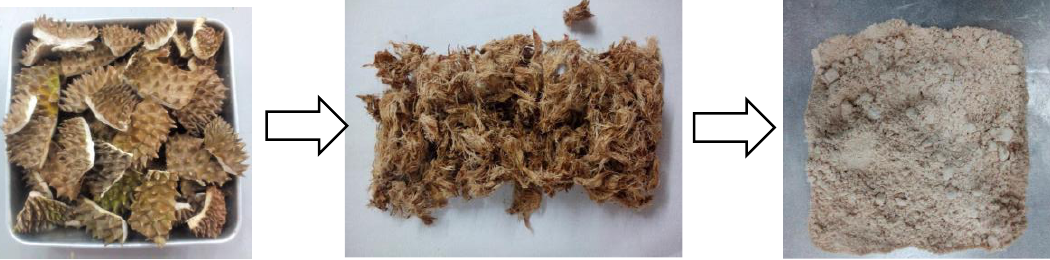
Figure 1: Preparation of durian skin fibre